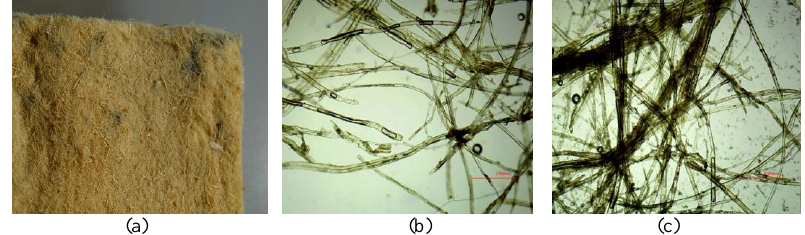
Fig. 7. Mold on wood fiber mat after test: a) mold on the top right corner, b) magnified wood fiber without mold, c) with